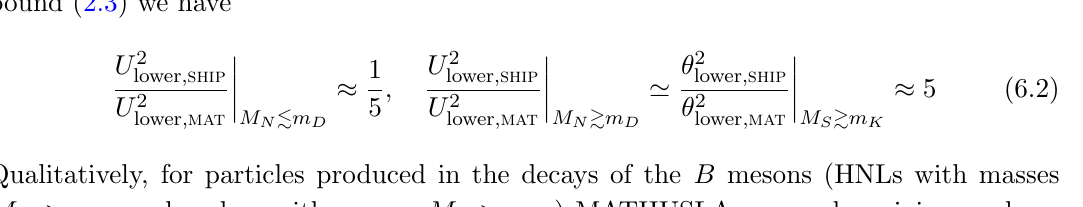
, the average length of the decay volume (see l det l target-det (cid:29) (cid:30) (cid:29) (cid:30) = N ¯ (cid:26) . M, eff M × X,M 7 8 times smaller at MATHUSLA. The latter is (cid:26) − ◦